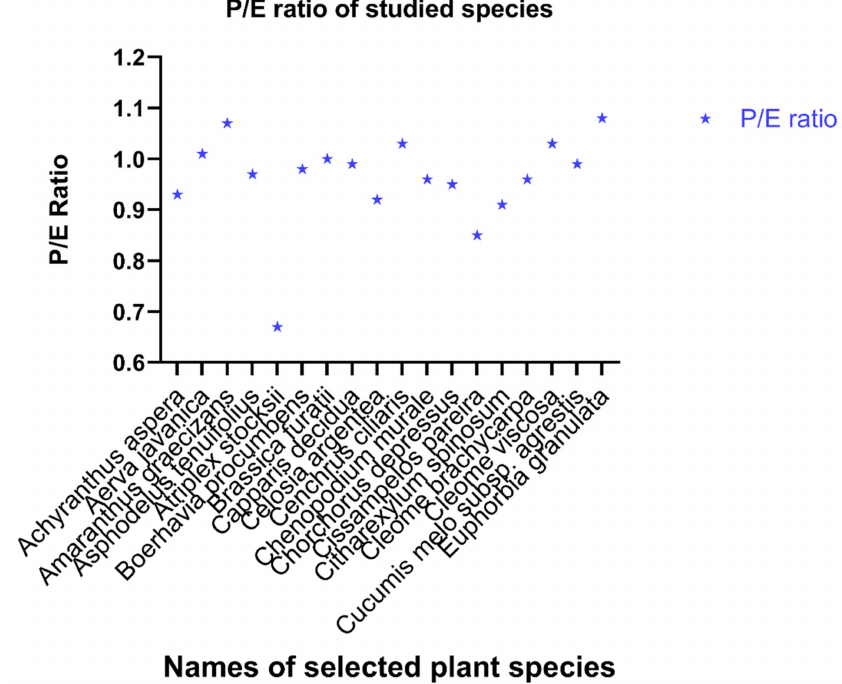
Figure 4. P/E ratio of different species of weeds collected from the Potohar region of